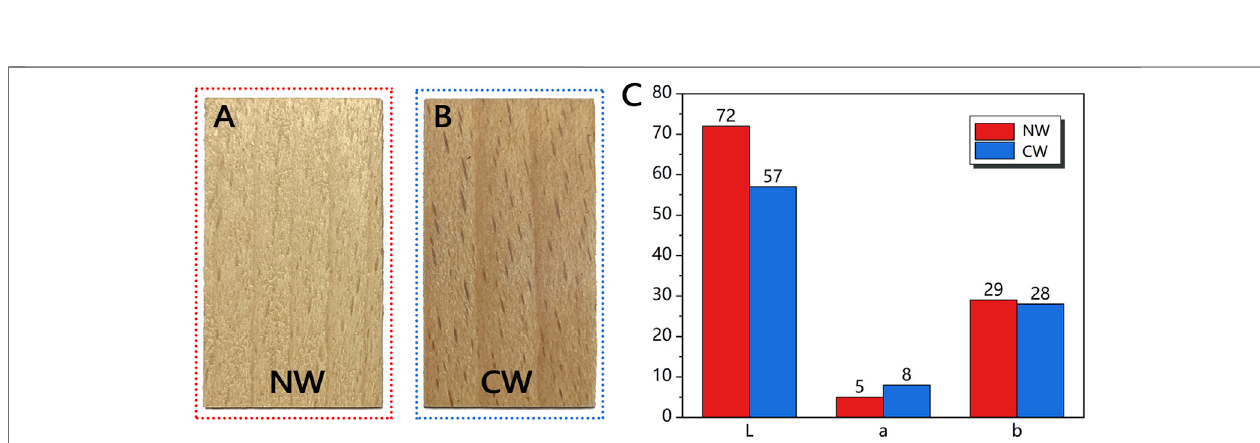
FIGURE 7 | Color change of NW and CW. (A) Digital image of NW. (B) Digital image of CW. (C) L, a, b values of NW and CW.